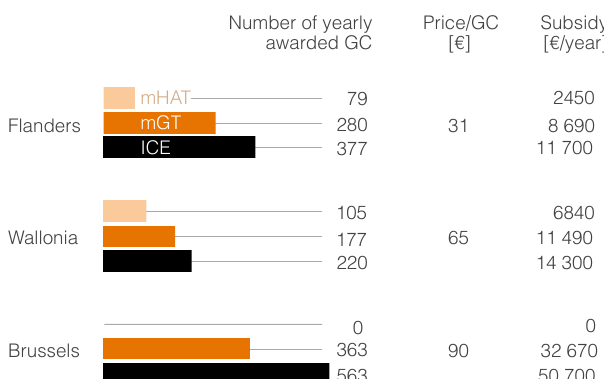
Figure 14. Brussels-capital is the region in Belgium giving the highest subsidies, although as it applies its own definition for PES, mHAT does not have access to GC.